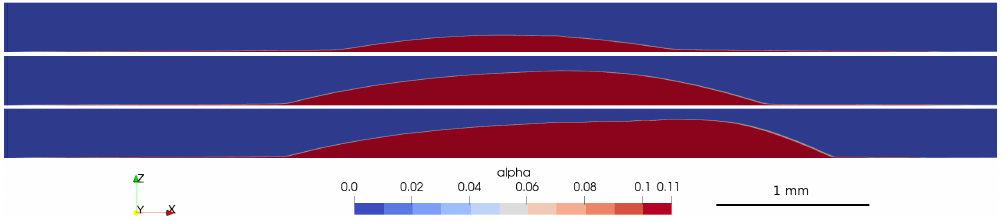
Figure 9. Nanoparticle phase evolution over the magnet during the aggregation procedure at the flow rate of Q = 150 mL · h − 1 .